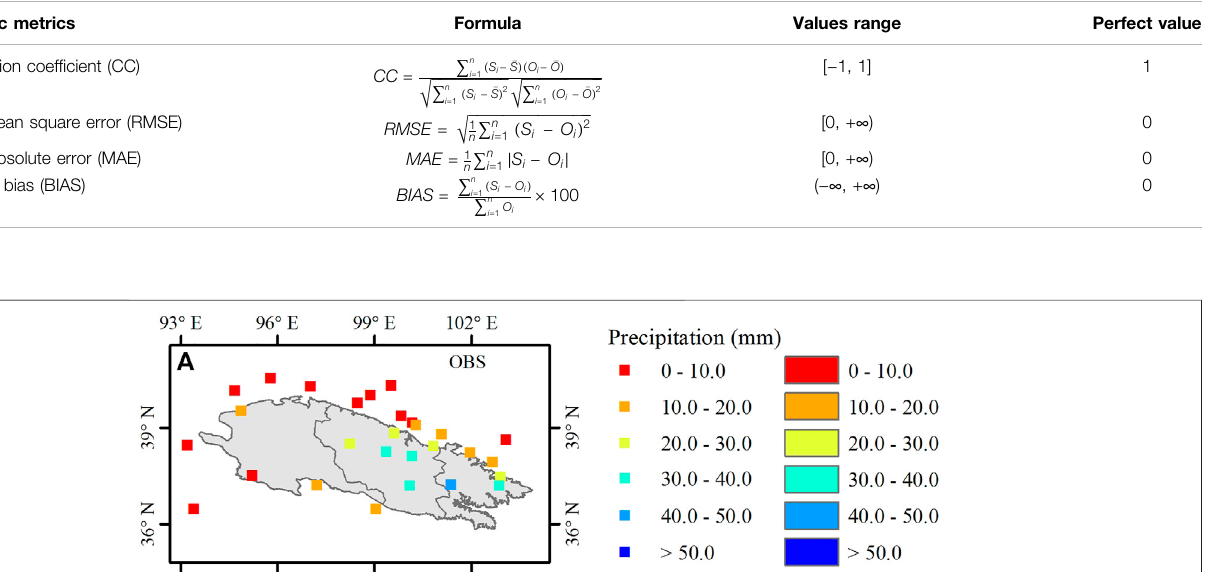
Frontiers in Environmental Science |